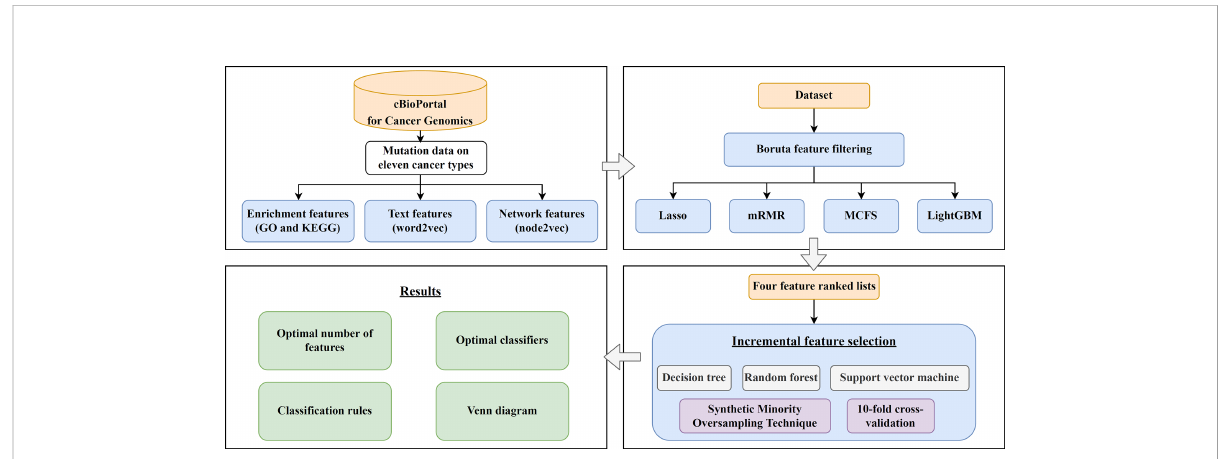
FIGURE 1 Computational framework of this study. First, the cancer samples obtained from the cBioPortal for Cancer Genomics database are represented by three feature types, derived by GO and KEGG enrichment, word2vec, and node2vec. Then, the Boruta feature fi ltering is adopted to exclude irrelevant features and retained features are ranked by Lasso, mRMR, MCFS, and LightGBM methods in four feature-ranked lists. These feature lists are subjected to incremental feature selection combined with classi fi cation algorithms to determine the optimal number of features, build optimal classi fi ers, and extract important classi fi cation rules. Furthermore, the Venn diagram analysis is conducted on the key features identi fi ed by different feature selection